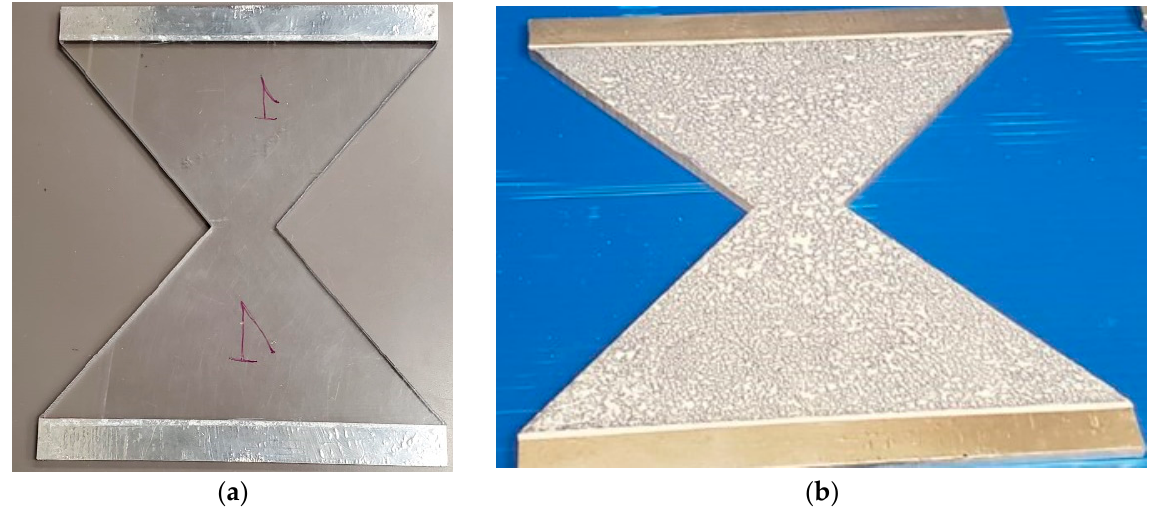
Figure 9. View of Plexiglass geometry before and after the pollution layer was obtained after drying using a low-pressure gun with ( a ) clean sample and ( b ) polluted sample.